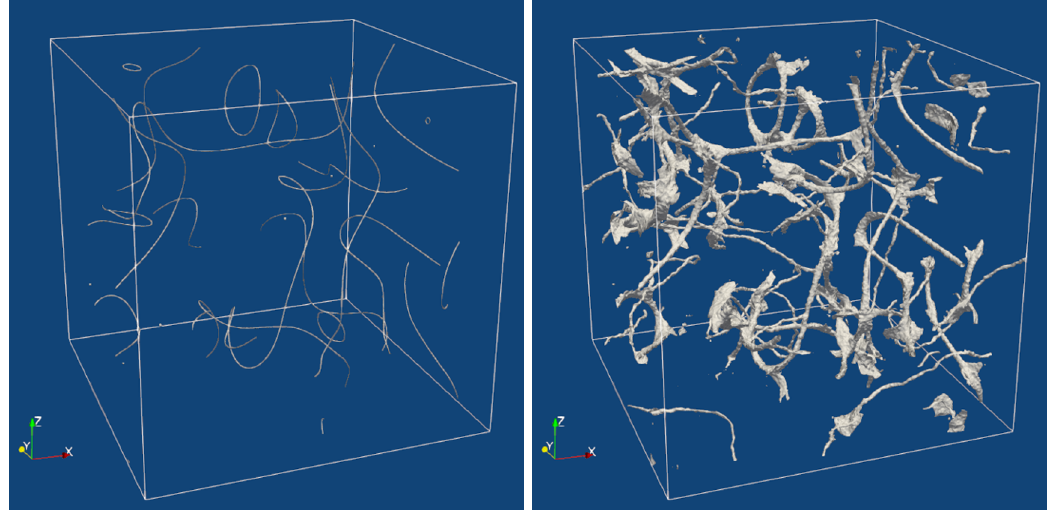
Figure 8 . Snapshots of the isosurface with j (cid:30) 1 j = 4 (cid:17) 1 = 5 ( left ) and j (cid:30) 2 j = (cid:17) 2 = 2 ( right ) at the simulation